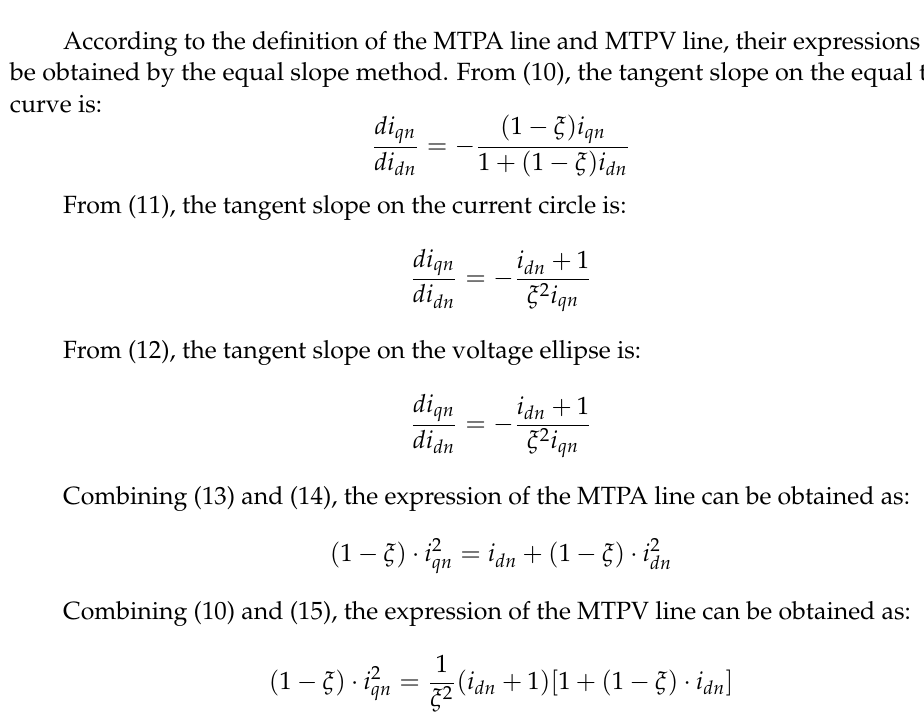
Figure 1. Characteristic curves of